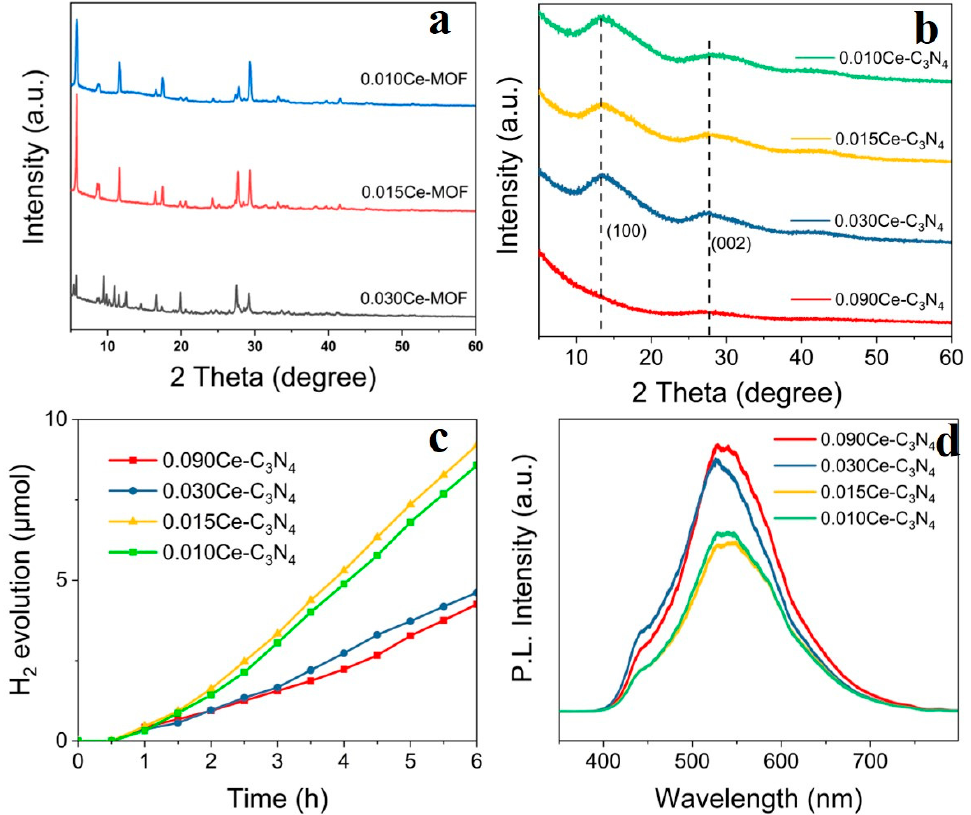
Figure 3. ( a ) XRD patterns for xCe-MOF (x = 0.010, 0.015, or 0.030 mol). ( b ) XRD patterns for xCe-C 3 N 4 (x = 0.010, 0.015, 0.030, or 0.090 mol). ( c ) H 2 evolution of xCe-C 3 N 4 (x = 0.010, 0.015, 0.030, or 0.090 mol) as a function of time. ( d ) Photoluminescence intensity of xCe-C 3 N 4 (x = 0.010, 0.015, 0.030, or 0.090 mol).